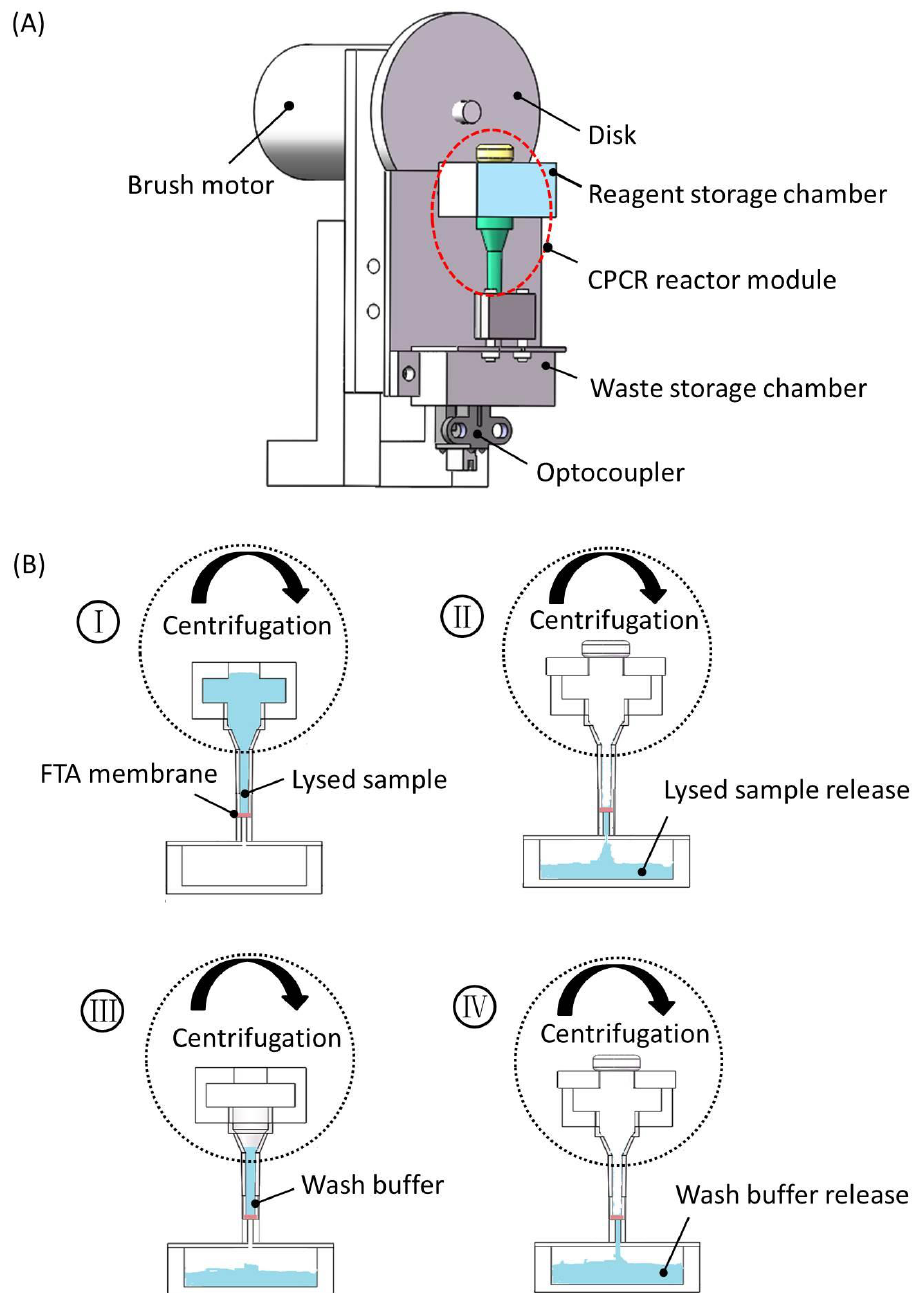
Figure 3. Centrifugation-based fluid control to CPCR reactor module. ( A ) Schematic depiction of CPCR reactor module with centrifugation; ( B ) schematic depiction of sample preparation process based on centrifugation.